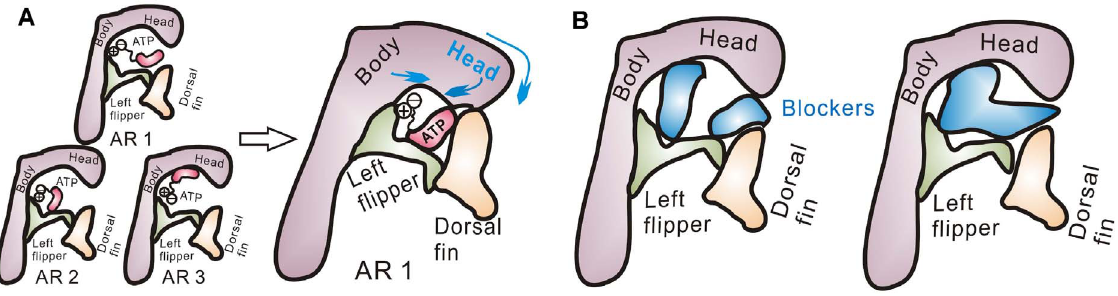
Figure 7. Illustrations of allosteric changes associated with AR determining and strategies to denovo design new blockers of P2X4 receptors. ( A ) Allosteric changes associated with zfP2 X 4 discriminating different AR modes. Light blue arrows denote the movements of key domains/regions crucial for AR determinants. ( B ) Illustrations of strategies to de novo design new blockers of P2 X 4 receptors.